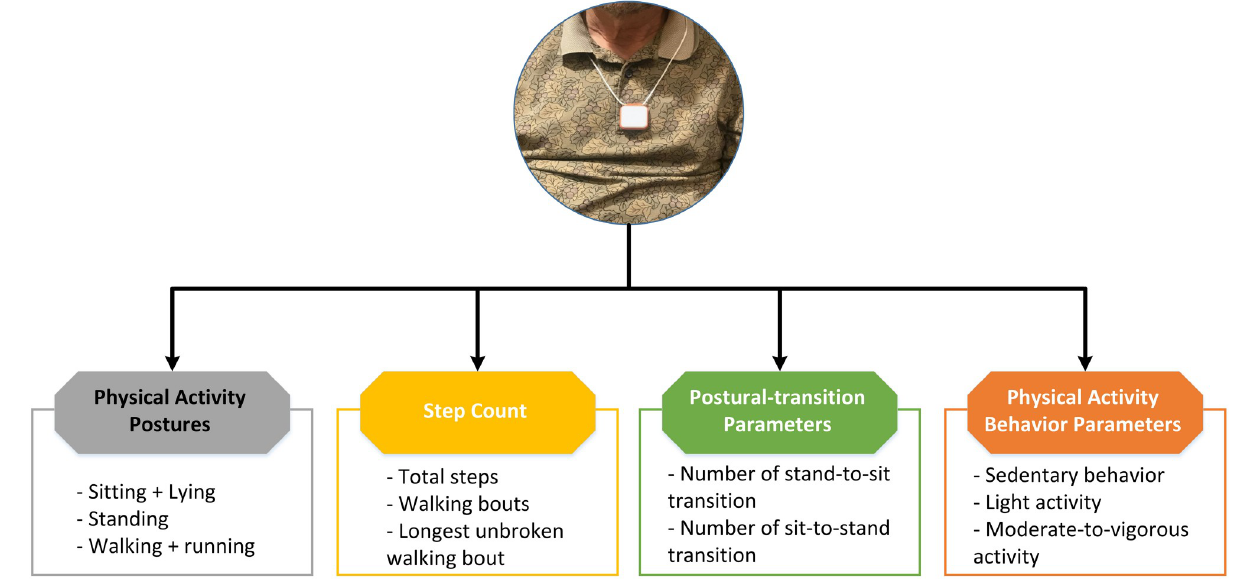
Fig 1. A wearable pendant sensor was used to monitor Daily Physical Activity